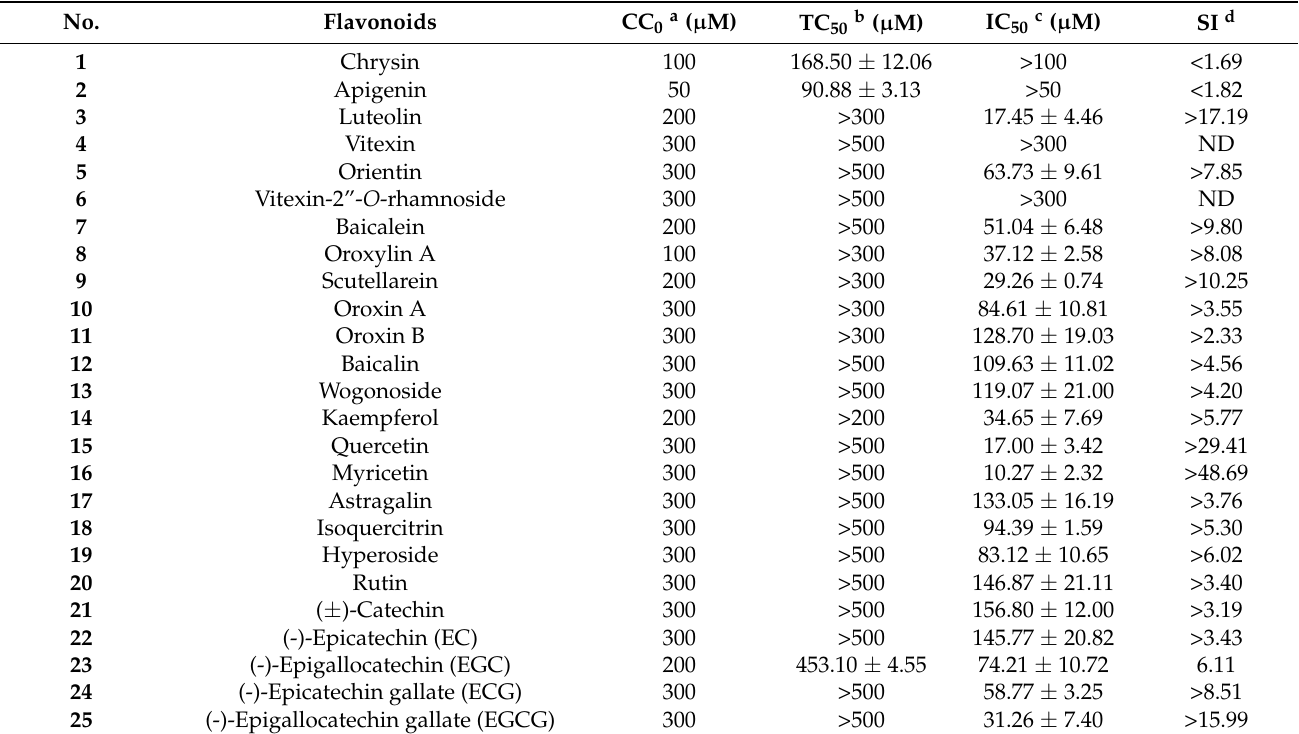
Table 1. The cytotoxic effects of flavonoids on HEK-293T-ACE2 h cells and inhibitory activities against SARS-CoV-2 pseudovirus’ entrance into host